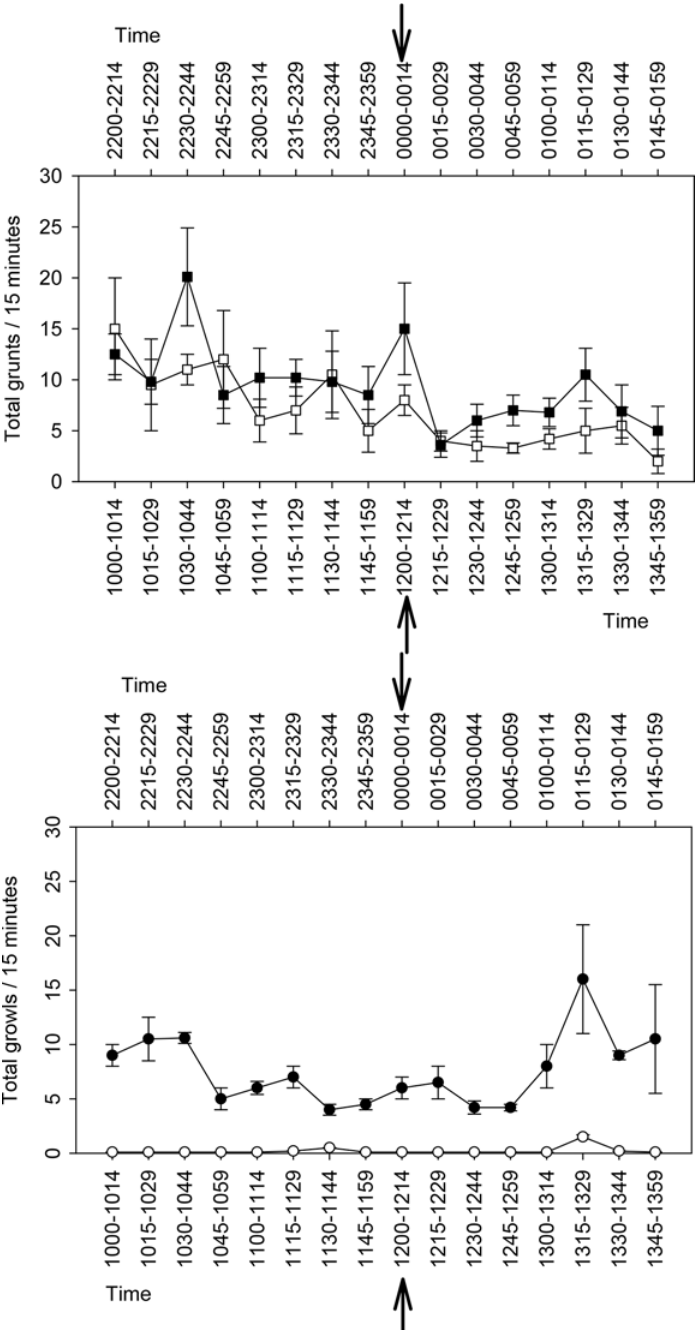
Fig 6. Total vocalisation counted in consecutive 15 min periods from 2 h prior to feeding, during feeding and 2 h after feeding commenced. 5a) Grunts and 5b) Growls. Counts of vocalisations were conducted for 5 non-consecutive days. Solid line and symbol = midnight; dotted line and hollow symbol = noon feeding. Vertical arrow indicates time of feeding. Data represent the mean values ±